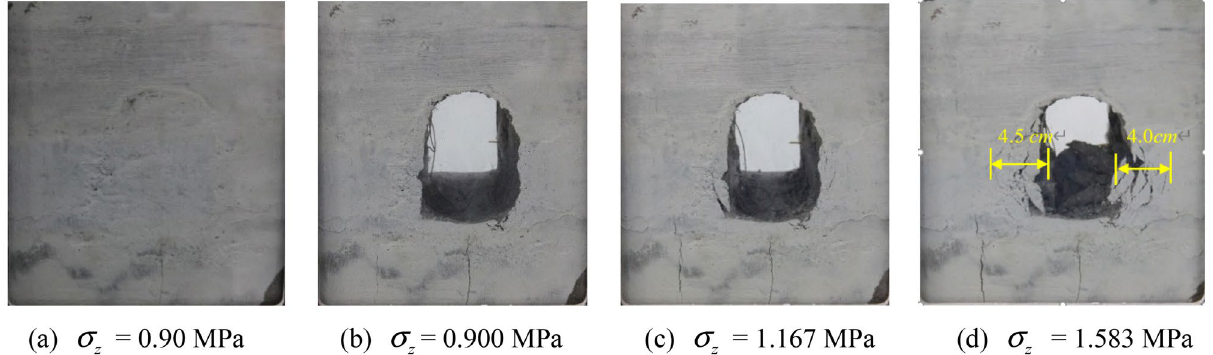
Figure 9. Fracture propagation during excavation unloading with surrounding rock stress of 60% σ zmax